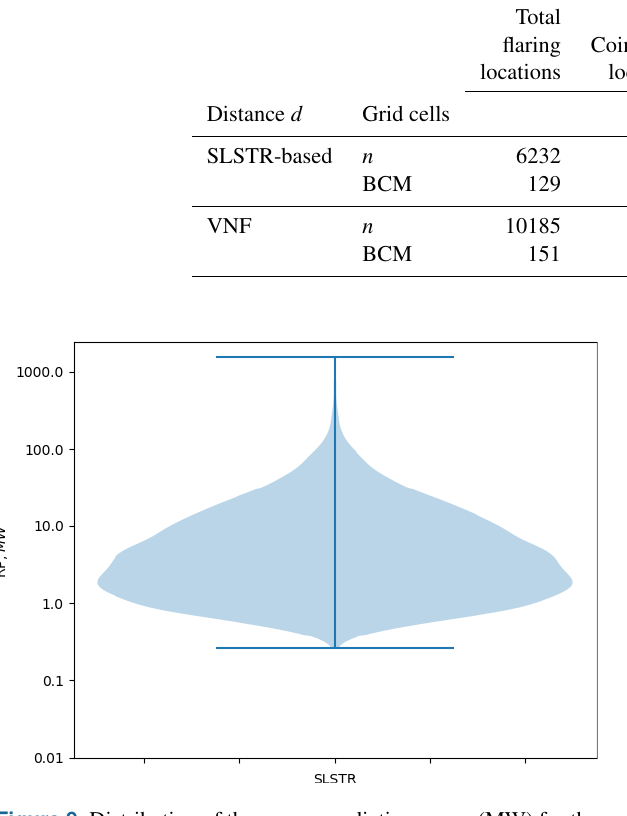
Figure 9. Distribution of the average radiative power (MW) for the 6232 global flaring